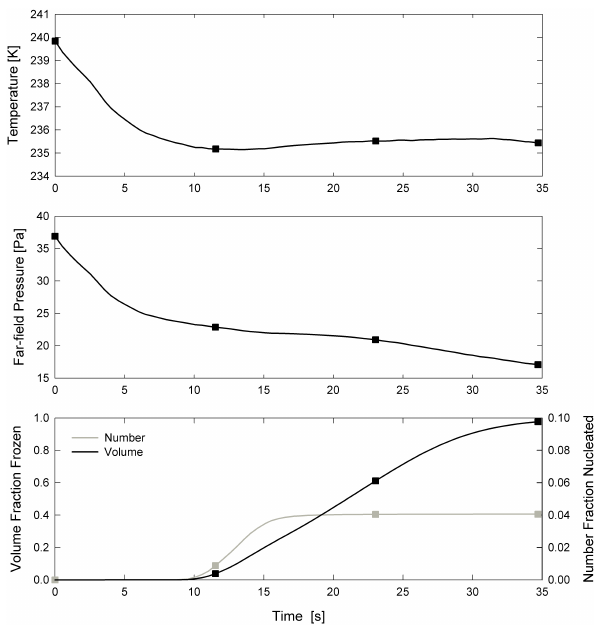
Fig. 7. Axial temperature profile and time evolution of far-field water vapour pressure, number fraction of droplets nucleated, and volume fraction of ice calculated by the model for the run at 235.7K (medium droplets). The solid squares indicate the times for which the volume distributions of supercooled water and ice are shown in Fig.